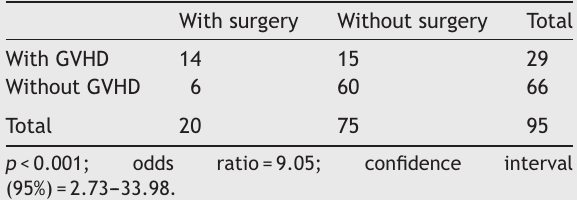
Association between sinonasal surgical treatment and graft vs. host disease (GVHD).